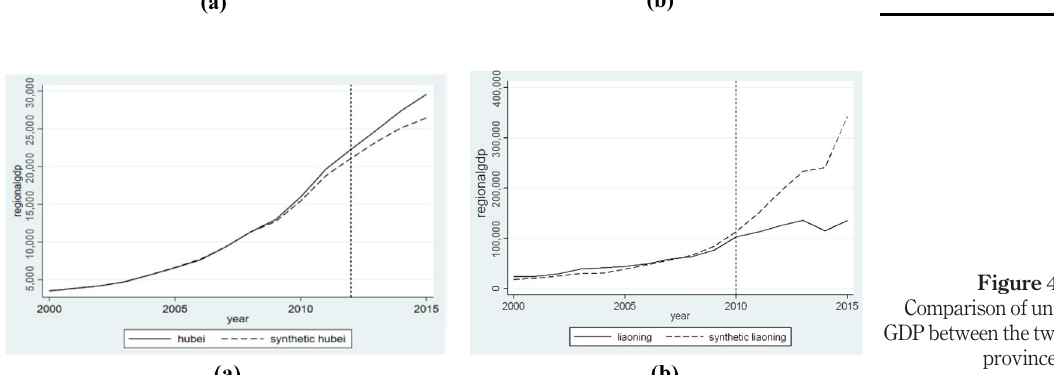
Figure 3. Comparison of the total carbon emission gap between Hubei Province (a), Liaoning Province (b) and synthetic Hubei Province and Liaoning Province